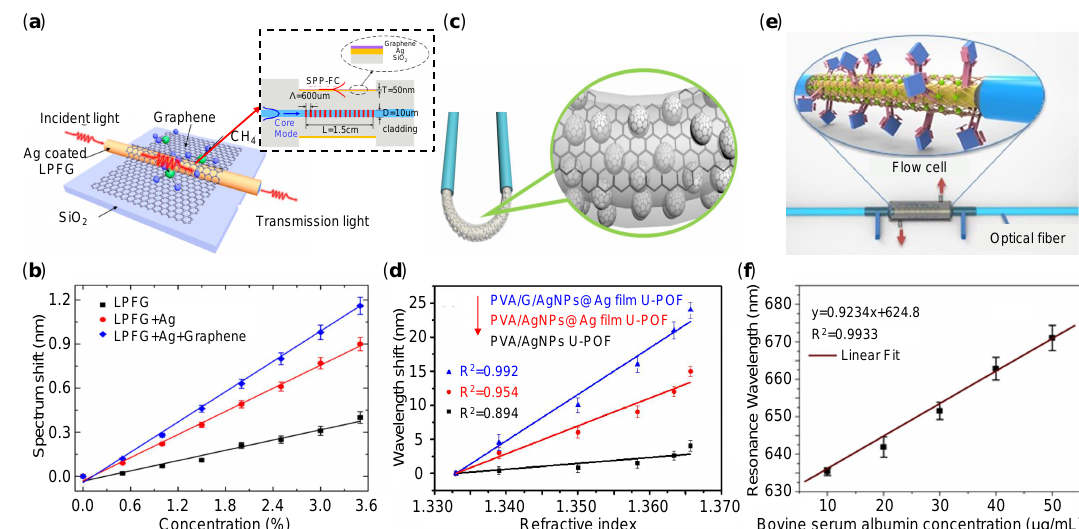
Figure 11. Plasmonic fiber sensors integrated with two-dimensional (2D) materials. ( a ) Schematic of the graphene-based LPFG-SPR sensor. Inset: longitudinal cross-section of the sensors. ( b ) Wavelength shift with the concentration of methane for LPFG (black), LPFG with Ag coating (red) and LPFG with Ag and graphene coating (blue) respectively. ( c ) Schematic diagram of U-shaped fiber coated with Ag NPs and graphene. ( d ) Wavelength shift as a function of RI for only Ag NPs (black), Ag NPs/Ag film (red) and Ag NPs/Ag film/graphene (blue) respectively. ( e ) Illustration of fiber coated with Au film and MoS 2 , and ( f ) wavelength shift with the concentration of bovine serum albumin solution. Reprinted ( a , b ) with permission from Reference [229]. Reprinted ( c , d ) with permission from Reference [194]. Reprinted ( e , f ) with permission from Reference